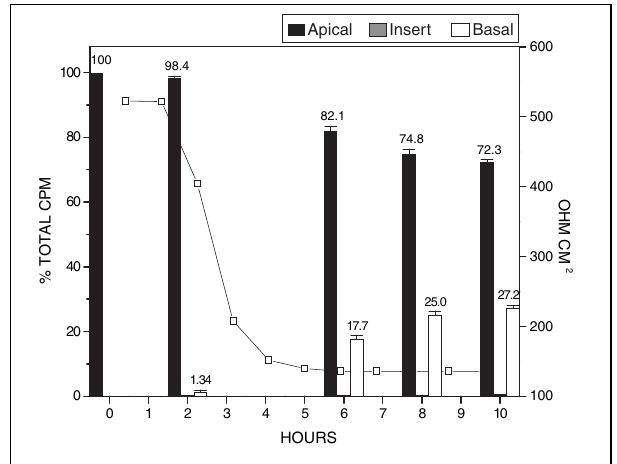
Figure 3) Radioactive count distribution for inserts treated with 125 I labelled toxin A and unlabeled toxin B. Inserts were inoculated with 250 µL of 125 I labelled toxin A (0.250 µg/mL) and 250 µL of unla- belled toxin B (0.250 µg/mL). Samples from apical, basal and insert were tested for percent of the total input counts per minute (cpm). The figure represents the average of three separate experiments. The electrical resistance measurements indicate the level of tight junction integrity. The total amount of radioactivity inoculated onto the insert in the form of radiolabelled toxin A was 4.6 × 10 3 cpm basal side of the insert at each time point tested when com- pared with treatment with 125 I-BSA alone. The amount of 125